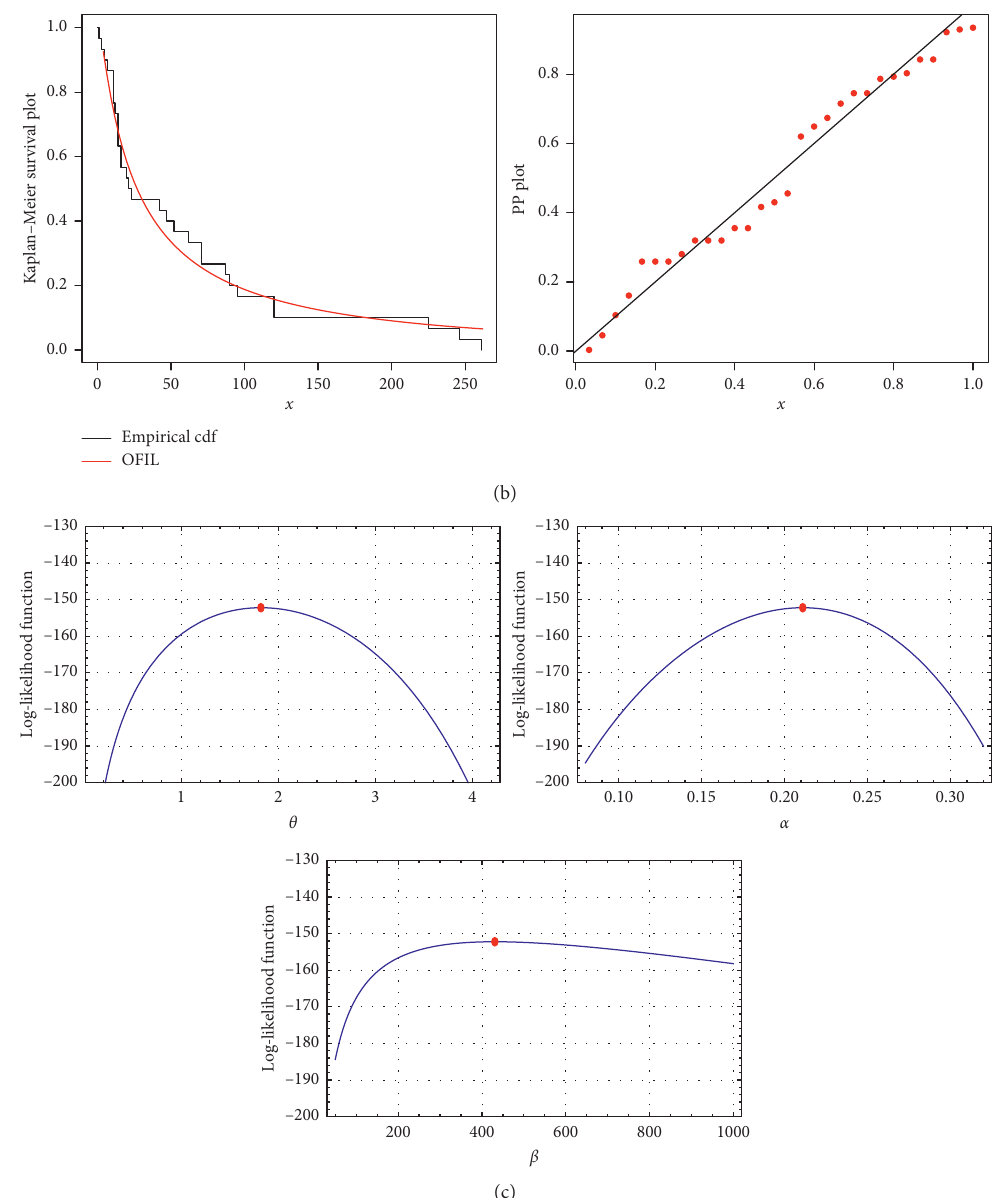
Figure 7: (a) Plots of the estimated pdf and cdf for data set III. (b) Plots of the estimated sf and PP plot for data set III. (c) Log-likelihood plots for data set